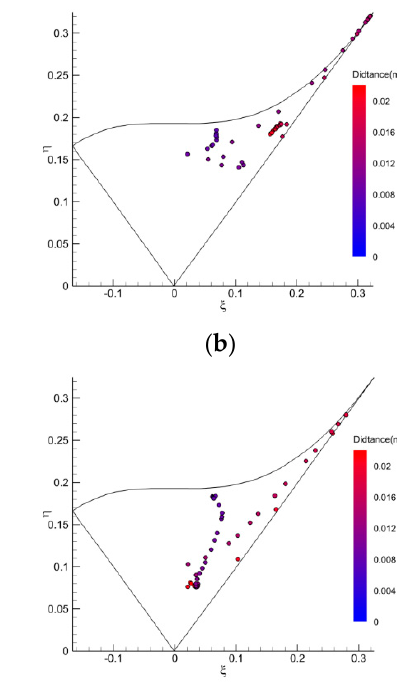
Figure 17. Distribution of points from the extracted lines in the Lumley triangle at 30% span: ( a ) No.1; ( b ) No.2; ( c ) No.3; ( d ) No.4.